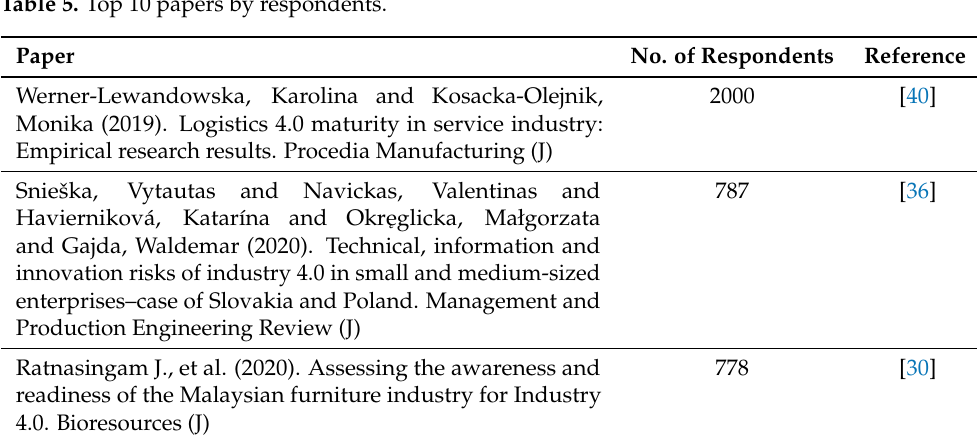
Table 5. Top 10 papers by